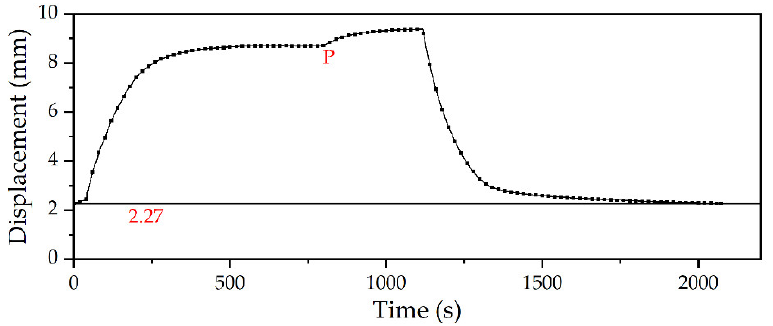
Figure 11. Supplementary experiment of residual displacement.